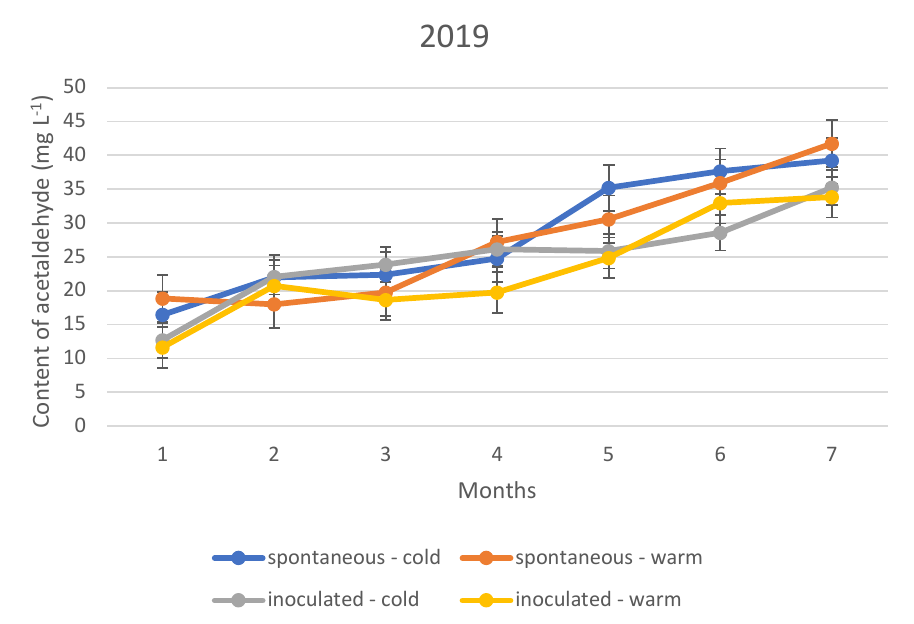
Figure 6. Acetaldehyde content of the wines tested during storage in 2019.